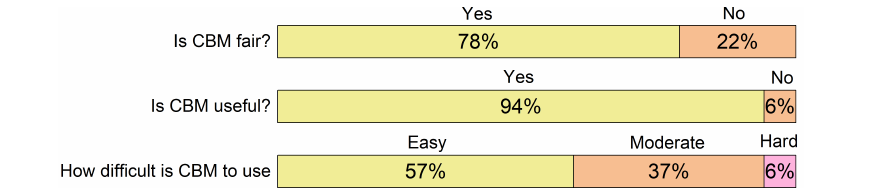
Figure 2. Students’ responses to the questionnaire after the CBM exam ( n = 49). The labels on the left represent the question or a series of questions that were given in the questionnaire. The text above the stacked bars represents the possible answers, while the width of the bar represents the portion of students who selected that answer.